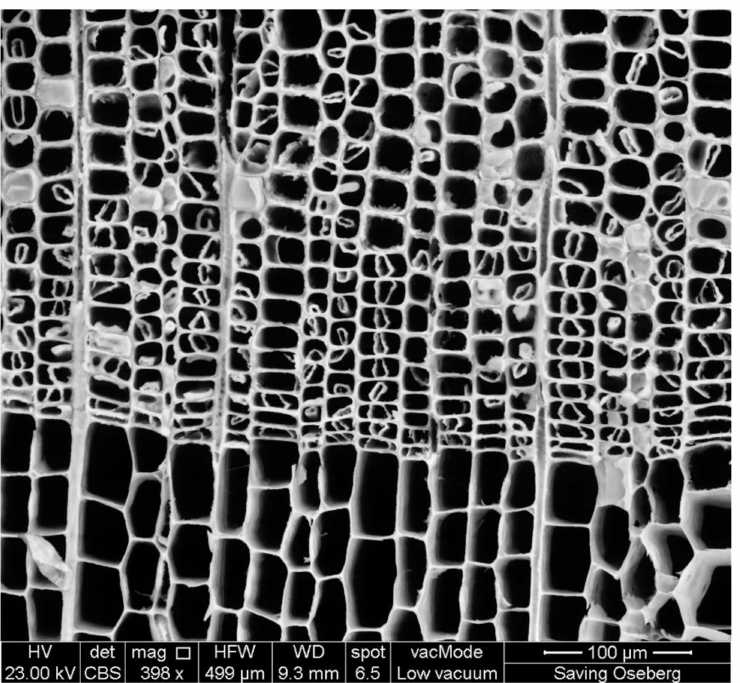
Figure 8. Scanning electron micrograph of a transverse section from historical waterlogged Picea abies wood. Latewood cells show severe degradation. There is pronounced secondary wall separation and collapse, with mainly parts of the primary wall and the middle lamella still in place. Seen also is the lumen of only a few latewood cells filled (or plugged) with 20% Paraloid B72 in acetone; the lumen of the earlywood cells remained empty after impregnation. The wood sample belongs to an assemblage of wooden stocks used for the construction of a road excavated from the medieval part of Oslo (ca. 1200–1300 CE). Image: A. Zisi, © Museum of Cultural